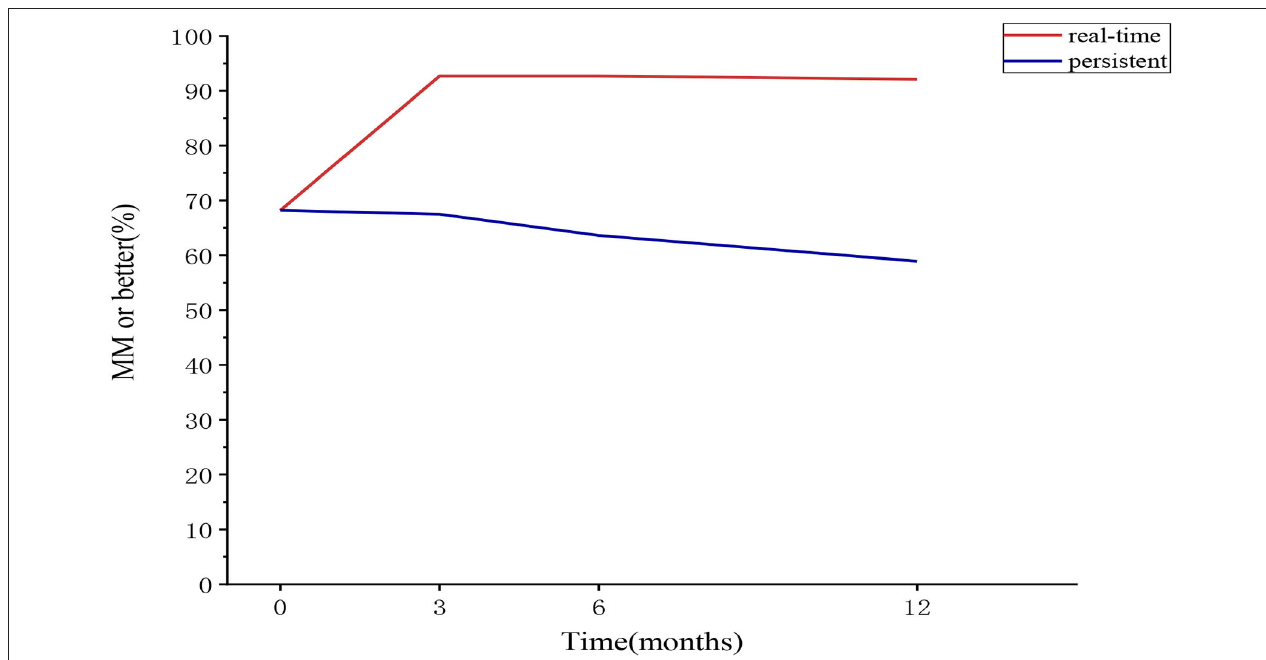
FIGURE 2 | The proportion of patients belonging to the “MM or better” category at each follow-up in the sensitivity analysis cohort (real-time and sustained). MM, minimal